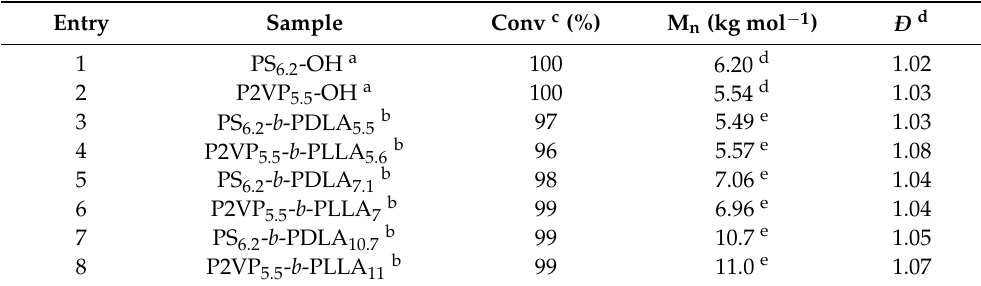
Table 1. Molecular characteristics of homopolymers, diblock copolymers, and the corresponding stereocomplex.